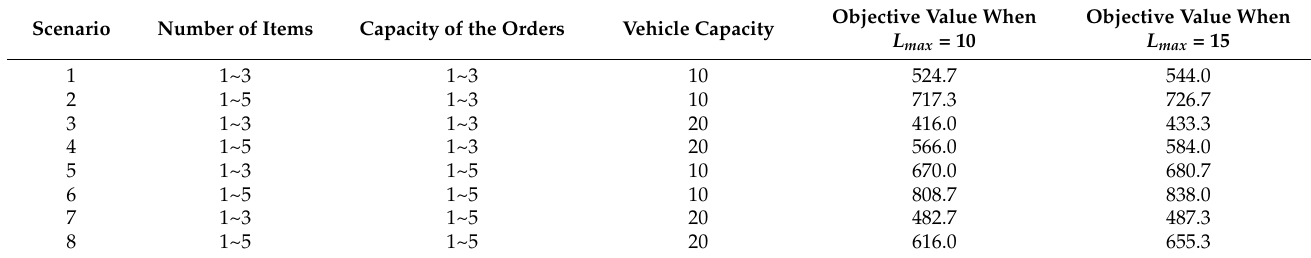
Table 6. Mean objective value of L max associated with 40 orders (unit: m).